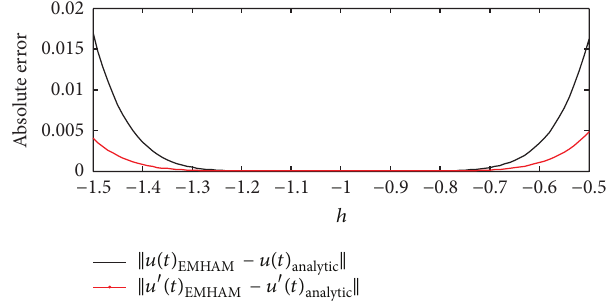
Figure 6: Absolute error plotted against the control parameter ℎ